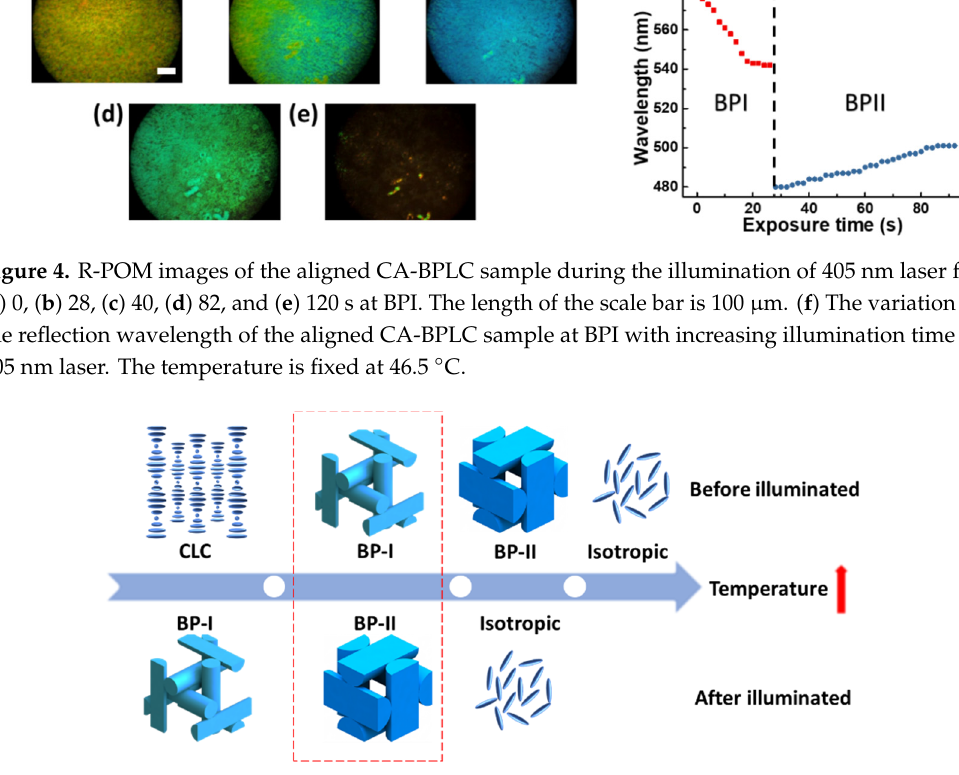
Figure 5. Schematic of the isothermal phase transition in the aligned CA-BPLC sample.